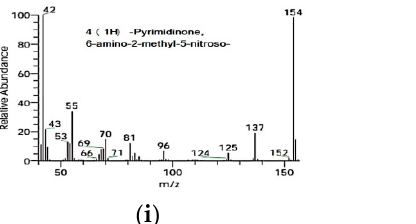
( i ) ( j ) Figure 10. GC and GC-MS chromatograms of metabolites mixture. Figure 10. GC and GC-MS chromatograms of metabolites mixture. Table 1. Identified compounds from degraded mixture through GC-MS analysis. Table 1. Identified compounds from degraded mixture through GC-MS analysis.